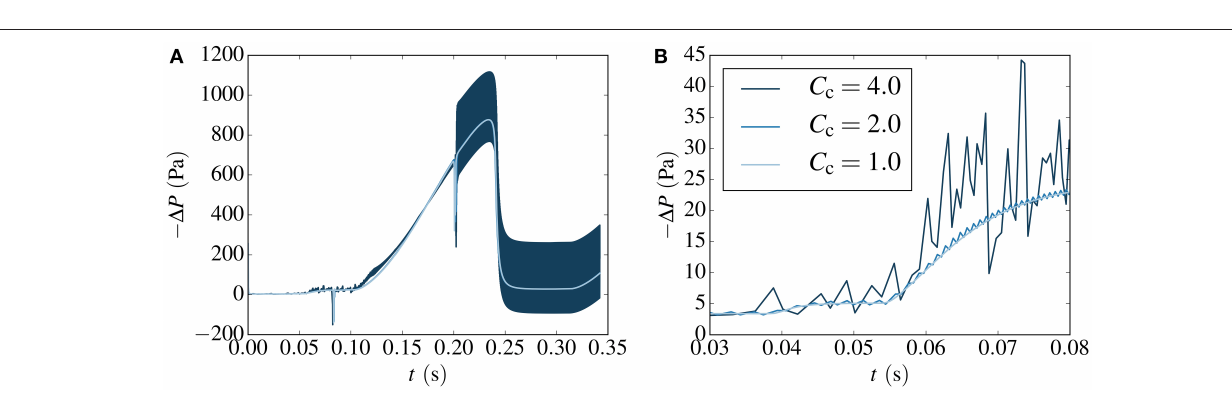
FIGURE 7 | Pressure difference required to drive the flow in the Haines jump case at a rate of Q = 10 − 9 m 3 s − 1 , corresponding to Ca = 1.2 · 10 − 5 . In (B) , the results from (A) are shown in greater detail. Results are computed with the forward Euler method for different values of the capillary time step restriction parameter C c . Numerical instabilities are seen to occur for C c >